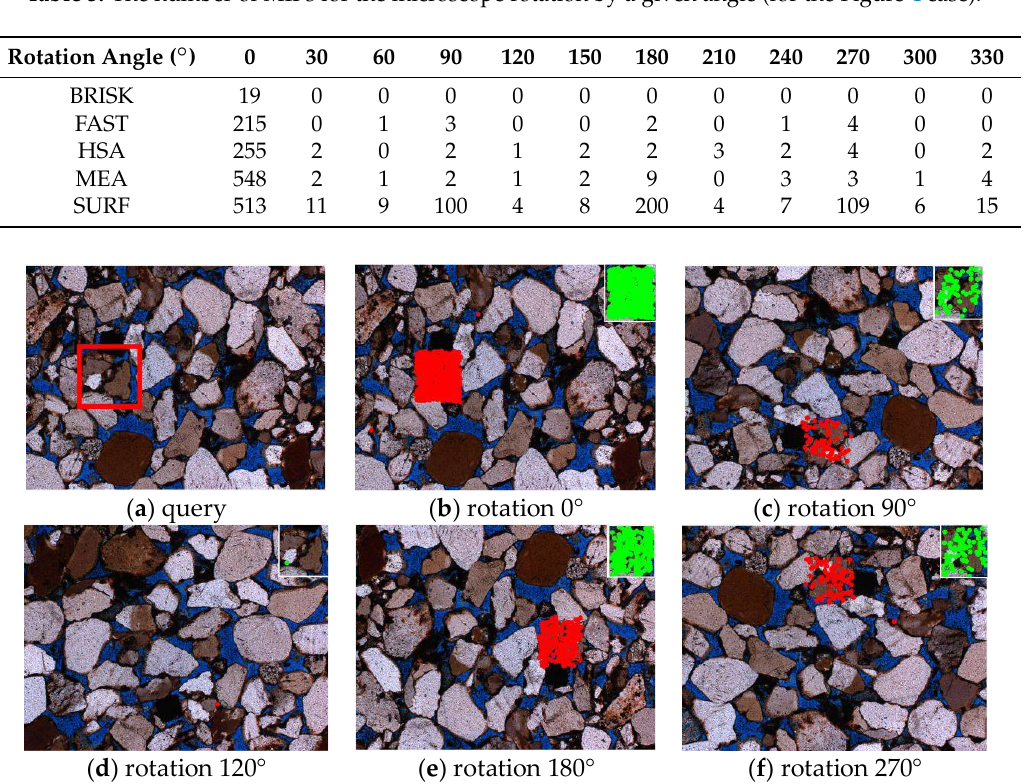
Table 2. The number of MIPs for the computer-aided rotation of the search key by the given rotation angle (for the Figure 3 case).